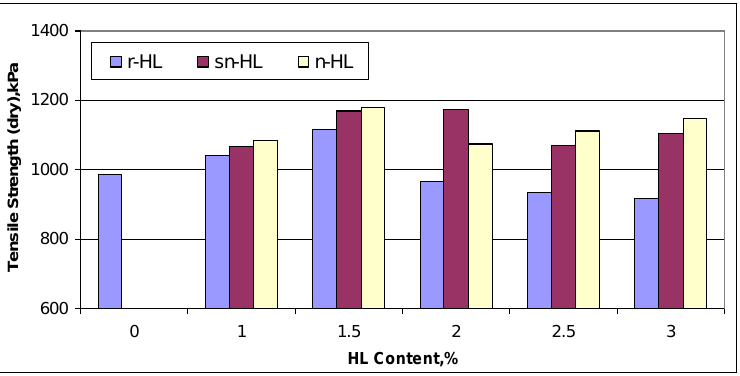
Figure 13. The dry tensile strength of the samples in the moisture susceptibility